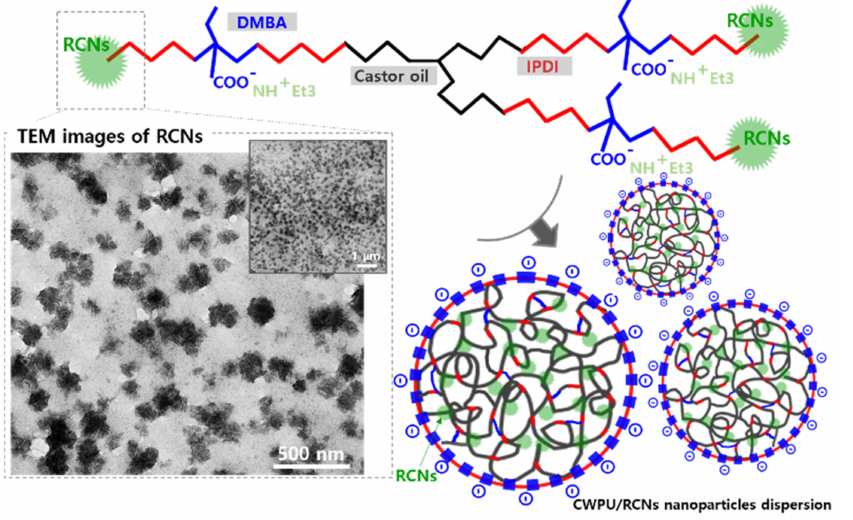
Figure 2. The structure of the fabricated CWPU/RCNs nanocomposites and TEM (inset figures)